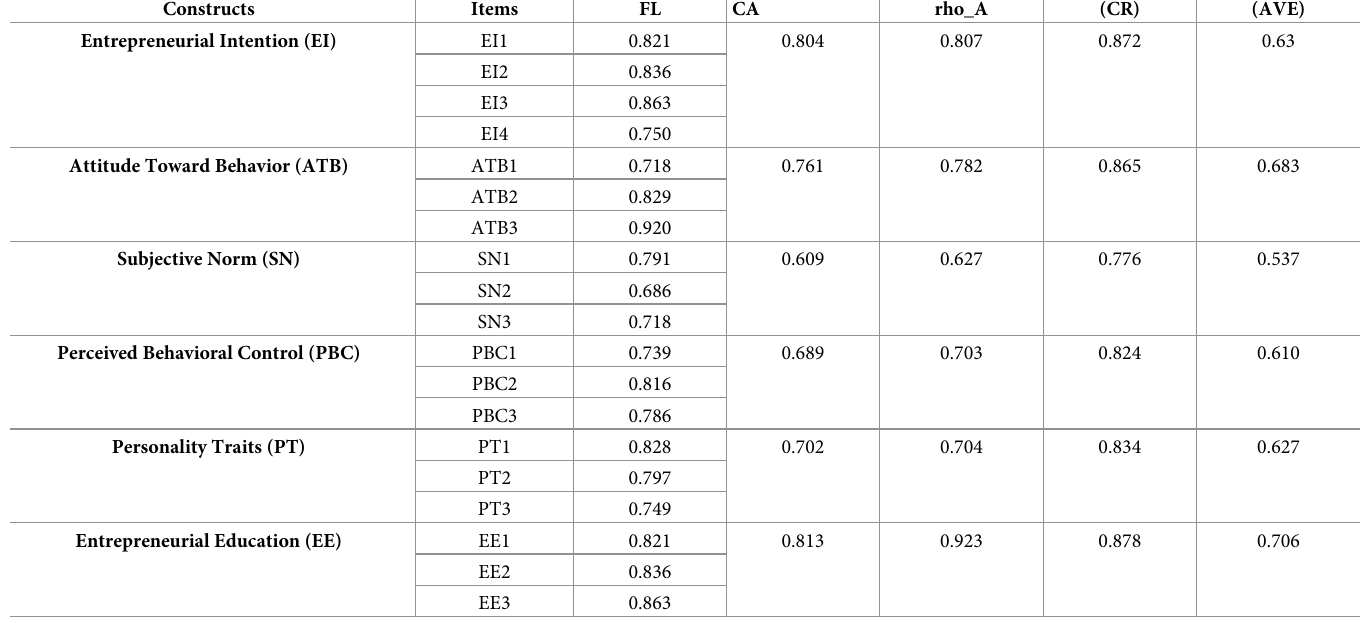
Table 2. Constructs reliability and validity test